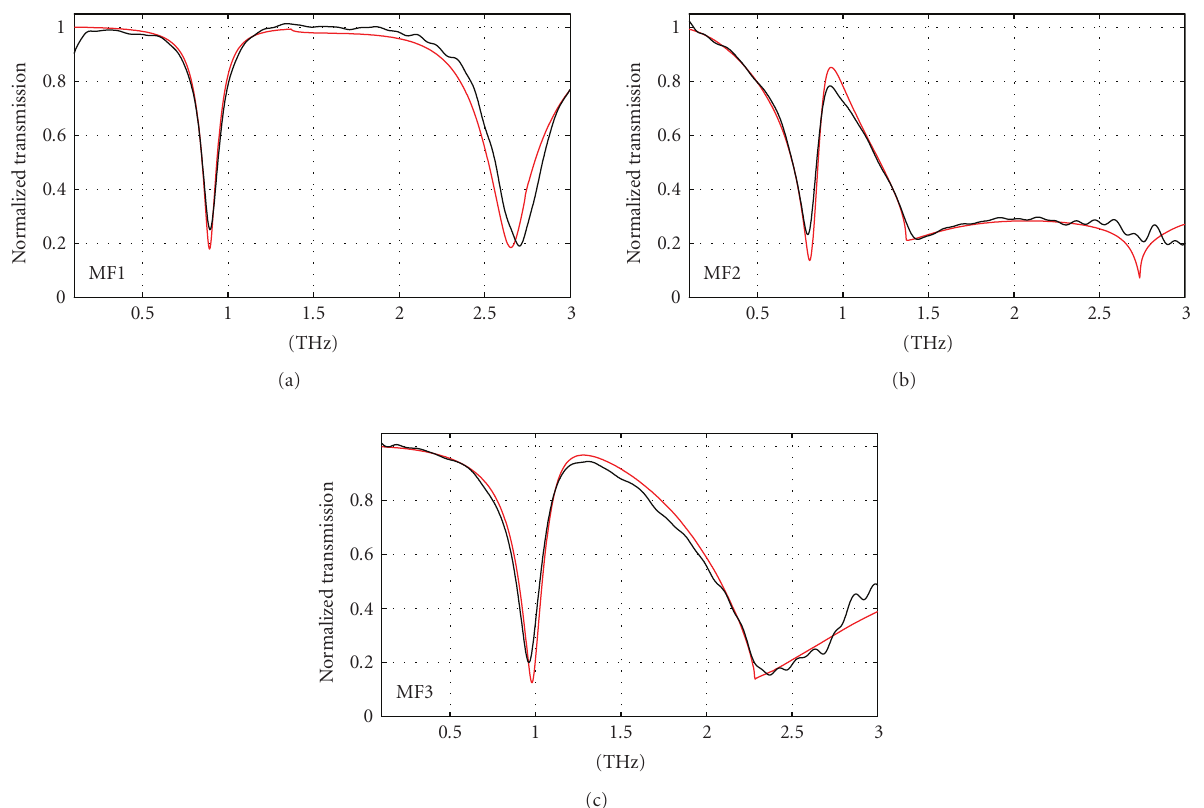
Figure 2: Normalized transmission through metafilm samples MF1, MF2, and MF3. Black curves indicate measured data while red curves show simulation